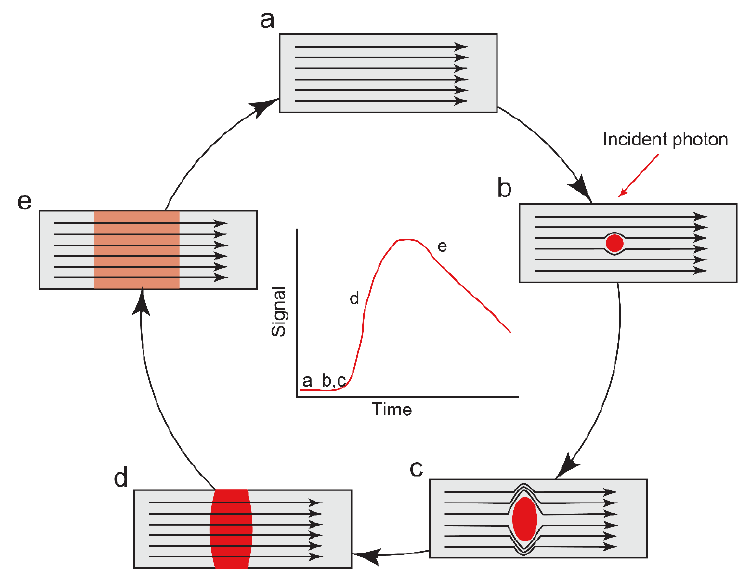
Figure 18. Schematic of the operating principle of the superconducting nanowire single photon detector (SSPD): The SSPD consists of a superconducting nanowire with a thickness of a few nanometers that senses photons. A bias electrical current flows through the nanowire during the operation: ( a ) the entire area is in the superconducting state prior to photon absorption; ( b ) single photon absorption takes place in the superconducting nanowire; ( c ) superconductivity is locally suppressed by energy excitation via the photon absorption; ( d ) the bias current makes the suppressed area resistive and the resistive area expands across the nanowire, which in turn generates a voltage spike; ( e ) as current is diverted, the resistive area relaxes to the superconducting state. Adapted with permission from [42]. Copyright 2020, American Chemical Society.